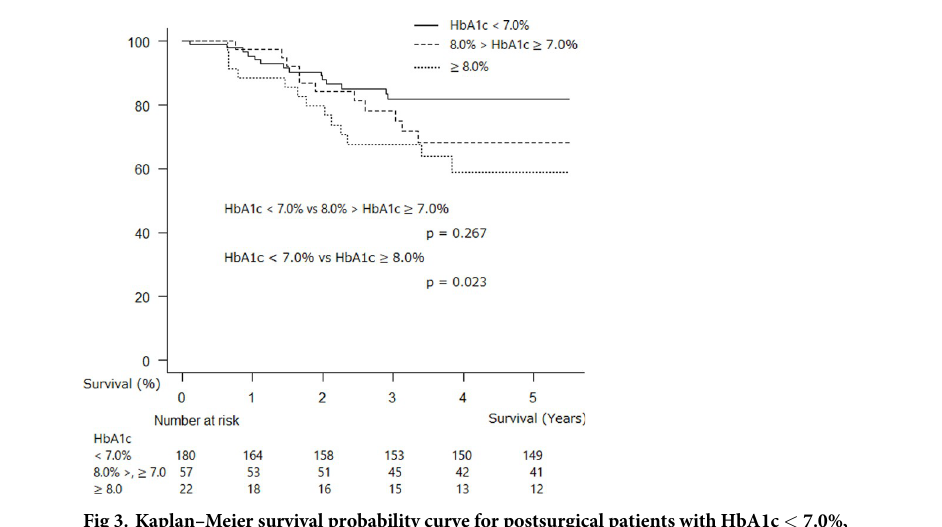
S1 Table. The included studies regarding the effect of DM on survivals in patients man- aged surgically for NSCLC.